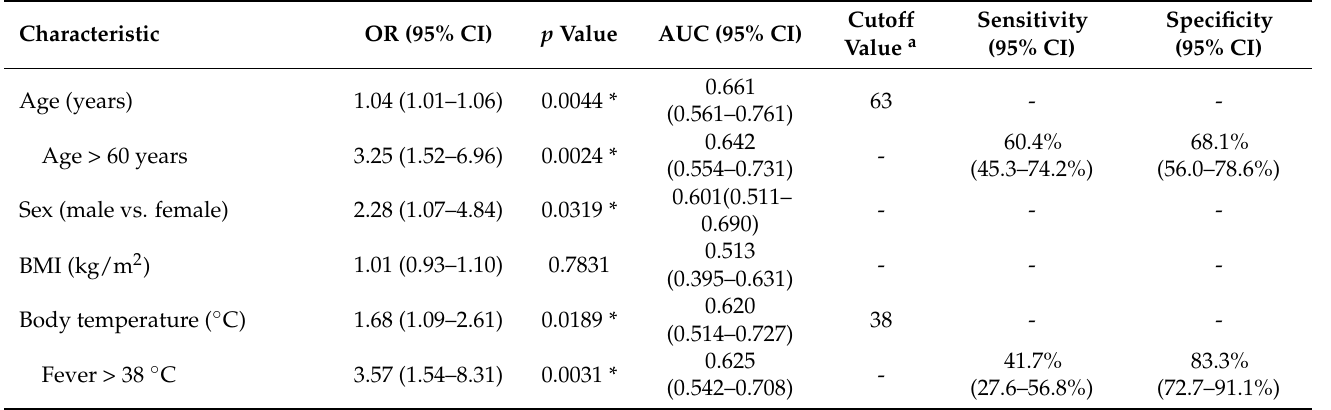
Table 2. Univariable predictors of length of stay >14 days ( n =